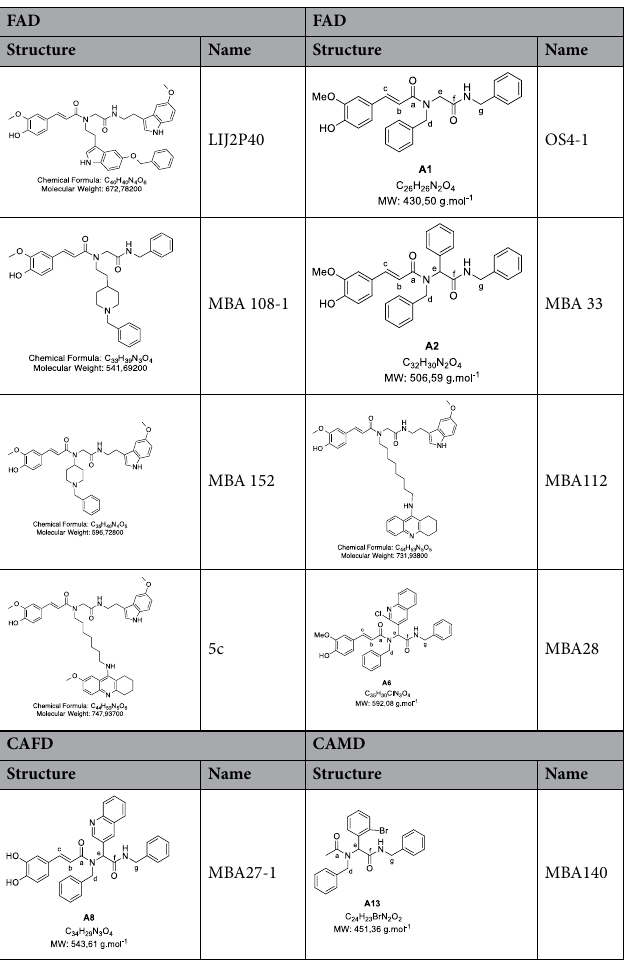
Table 1. The ten small-molecules tested belonging to the FADs, the CAFDs or the